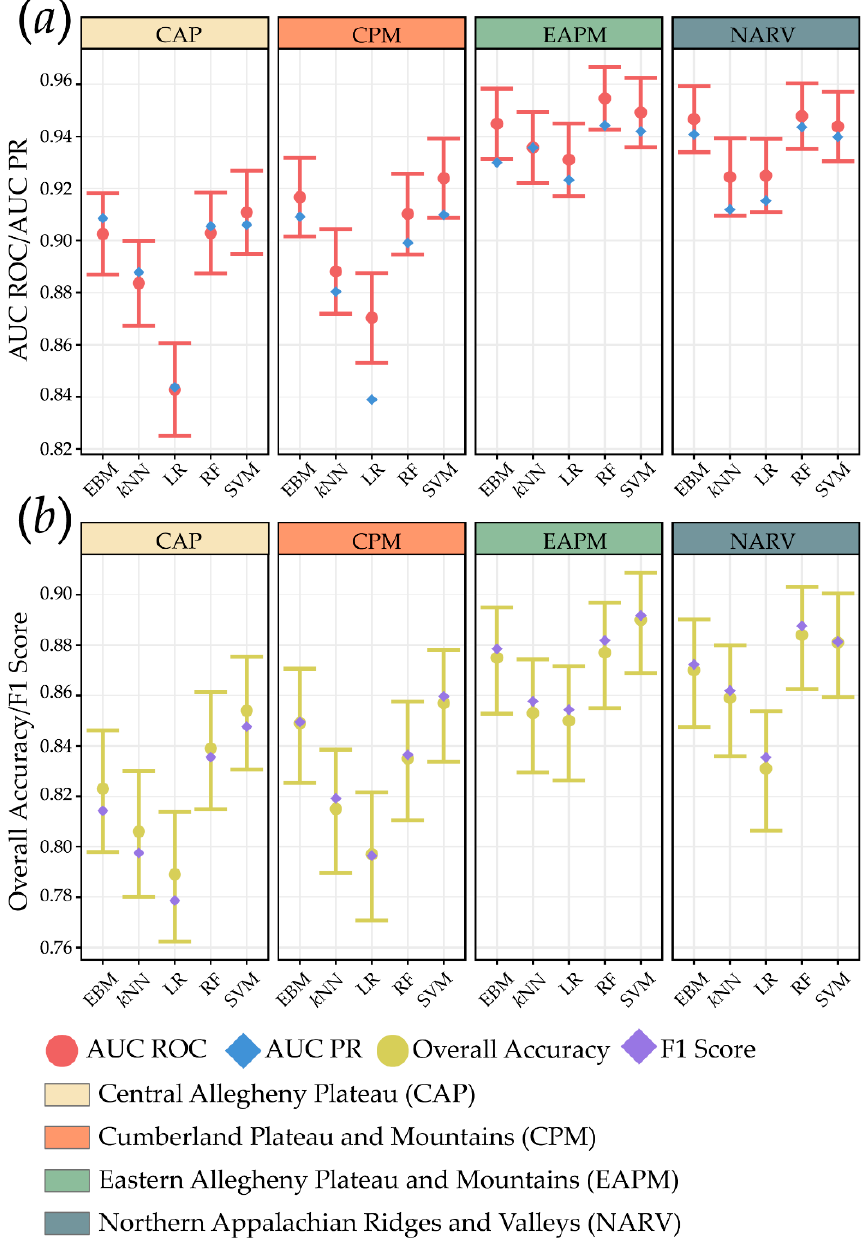
Figure 4. Model comparison and assessment using the withheld validation data for each algorithm in each MLRA study area. Bars for OA and AUC PR represent an estimated 95% confidence interval. ( a ) AUC ROC and AUC PR; ( b ) overall accuracy and F1 score.